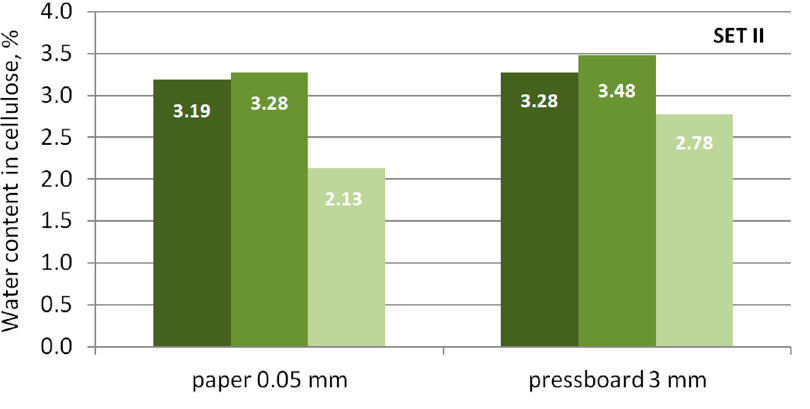
Figure 9. Water content in cellulose materials used in SET II before and after the drying process (70 ° C, 168 h).